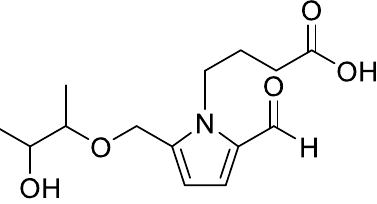
Figure 5. Structure of morrole A from Morus alba L.